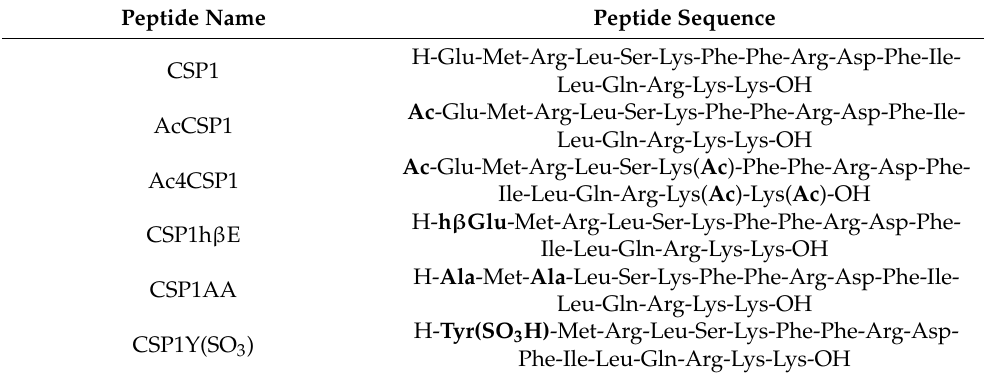
Table 1. Sequences of the synthetic peptides.